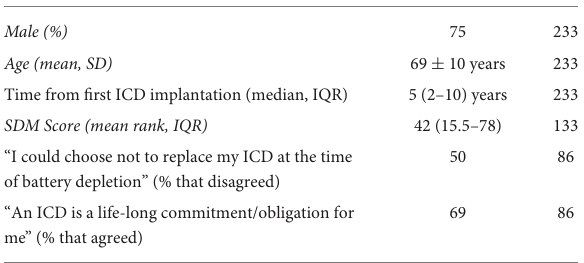
TABLE 2B Stage 2B: Patient history of shared decision